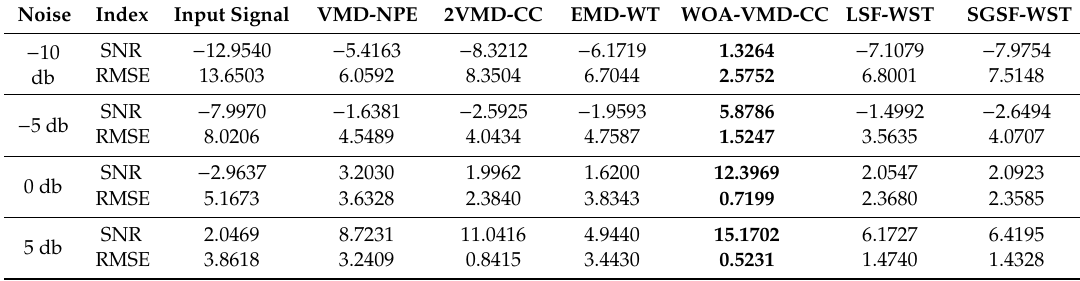
Figure 9. Denoising and baseline drift removal results of traditional digital signal processing methods in di ff erent noise intensity environments. ( a ) LSF-WST; ( b ) SGSF-WST. Table 3. Di ff erent denoising evaluation indexes of di ff erent algorithms under di ff erent decibel noises.